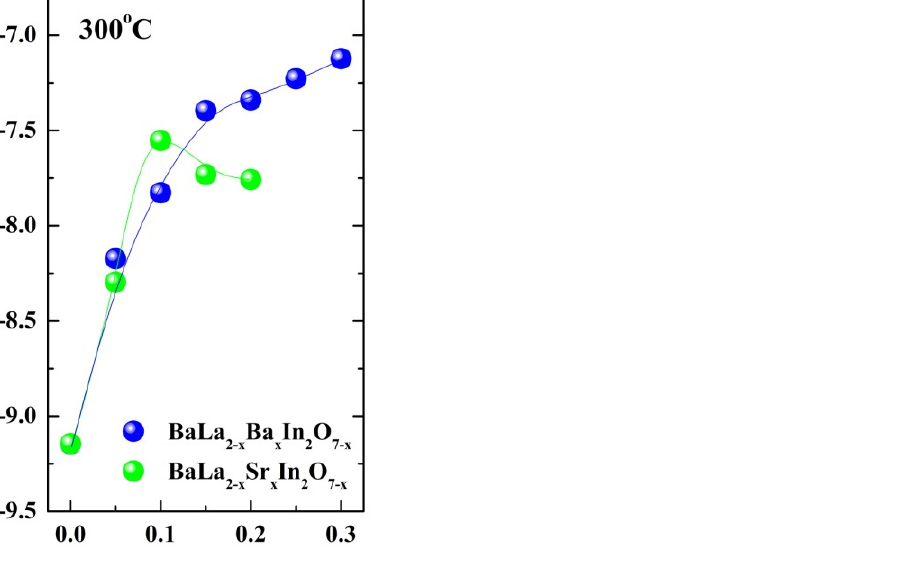
Figure 10. The concentration dependencies of oxygen ions mobility at 300 °C for the solid solutions BaLa 2 − x Ba x In 2 O 7 − 0.5 x and BaLa 2 − x Sr x In 2 O 7 − 0.5 x .